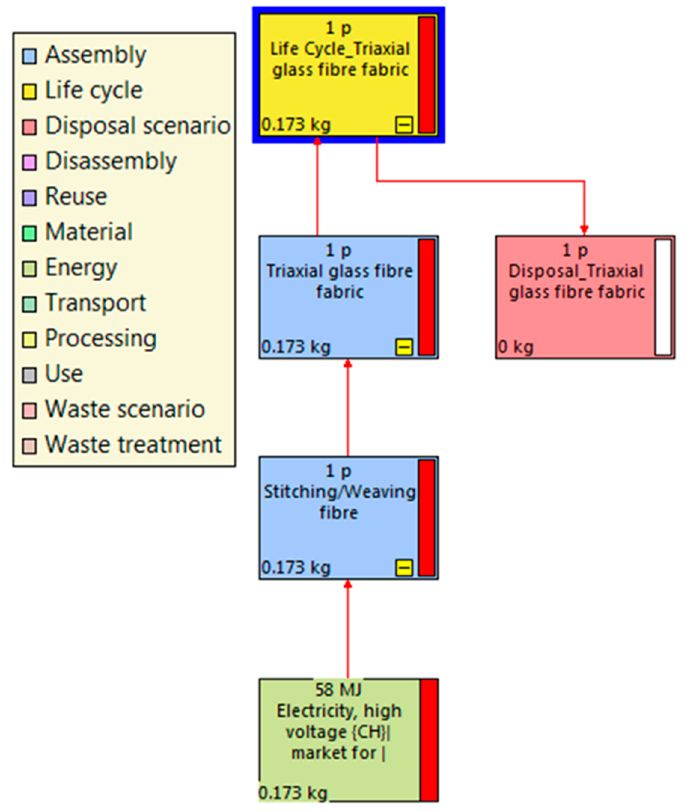
Figure 8. LCA SimaPro 8 simulation for the triaxial glass fabric production process.